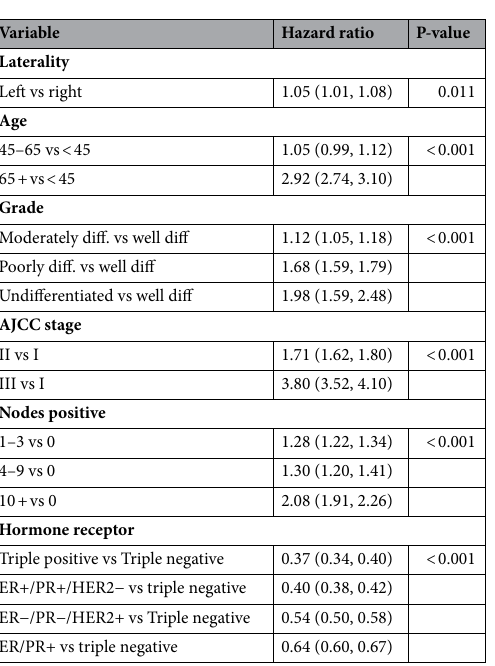
Table 4. Multivariate survival analysis while adjusting for grade, stage and tumor subtype. Yr year, CI confidence interval, ER estrogen receptor, PR progesterone receptor, HER2 human epidermal growth factor receptor 2, AJCC American Joint Committee on